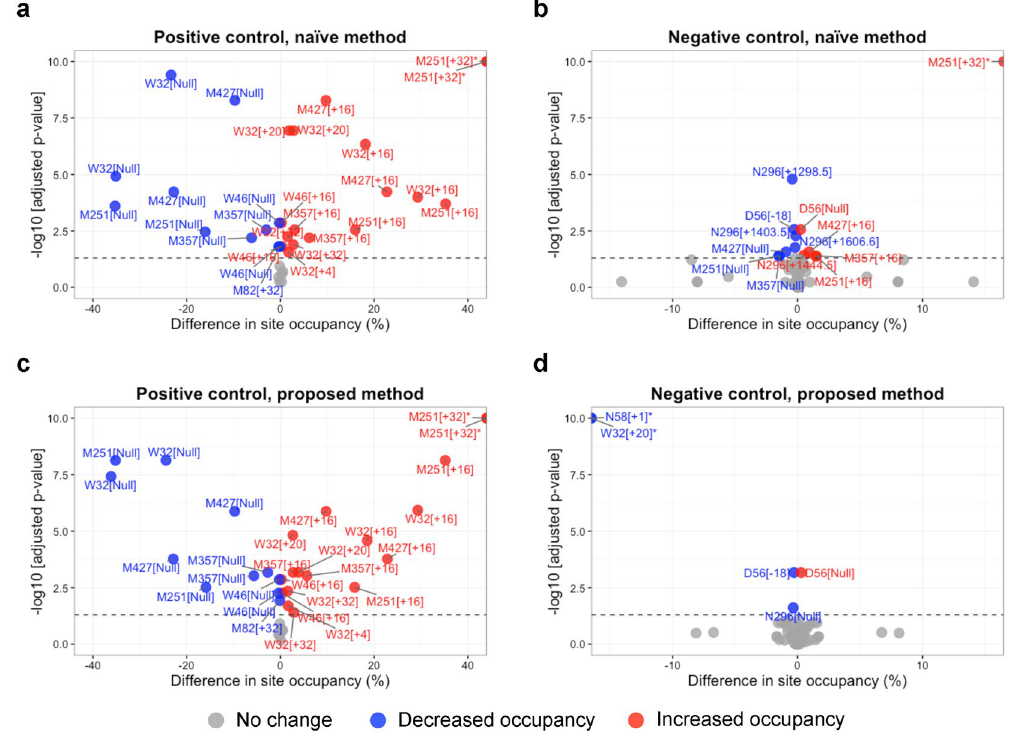
Figure 6. Goal 2: differential site occupancy. Volcano plots for the tests of differential site occupancy based on H 0(1) . Each dot represents the testing result for differential site occupancy of one form. X-axis: practical significance, difference in site occupancy between conditions. Y-axis: statistical significance, FDR-adjusted p -values on the negative log10 scale. The horizontal dashed lines represent the 0.05 FDR cutoff. Forms with decreased and increased site occupancies are shown in blue and red colors, respectively. ( a ) Comparison of sites in Fab and Fc between AI 3 mM AAPH or AI 10 mM AAPH versus AI reference by the naïve method. All forms are expected to change in the comparison (positive control). ( b ) Comparison between ADC reference versus AI reference by the naïve method, excluding the sites for drug modifications. None of the forms is expected to change in the comparison (negative control). ( c ) As in ( a ), but by the proposed method. ( d ) As in ( b ), but by the proposed method.